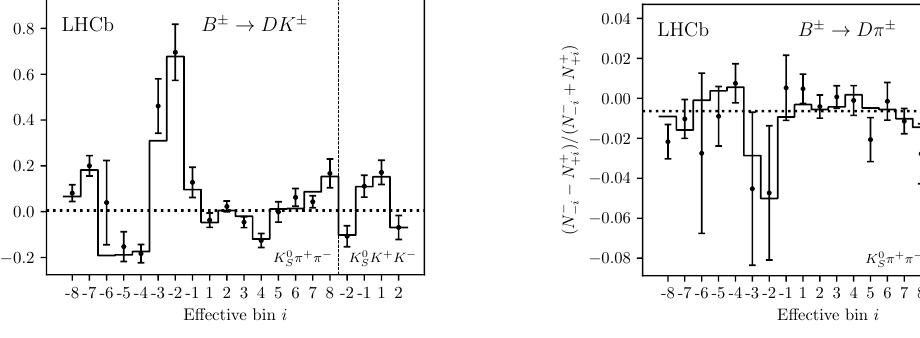
, y DK , x Dπ , and y Dπ . All uncertainties ± ± ξ ξ